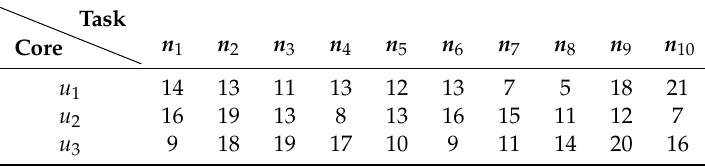
Table 2. Execution time of tasks on di ff erent processors with the maximum frequency of the application in Figure